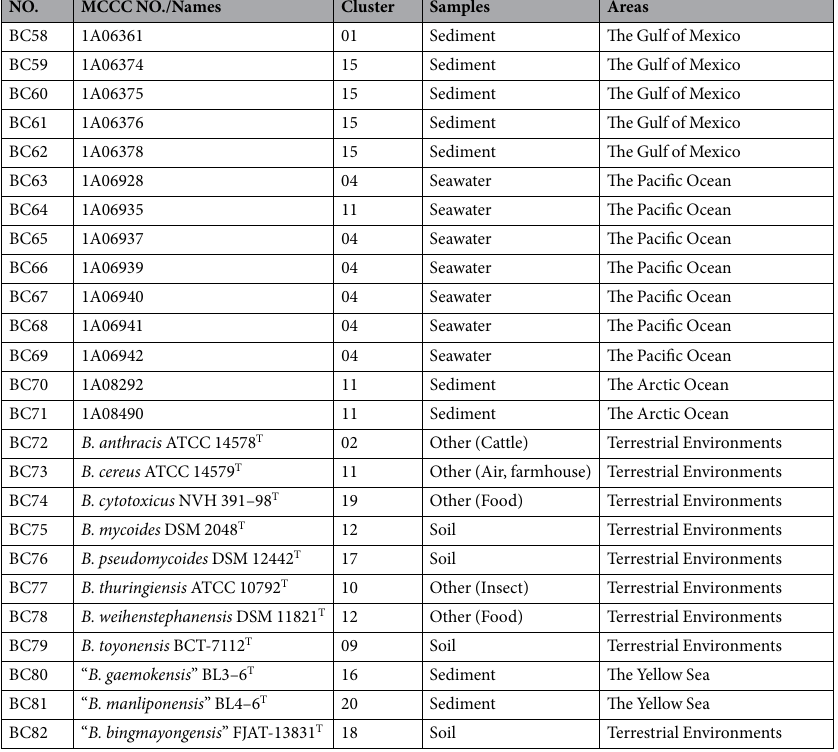
Table 1. Complete list of 82 strains used in this study with detailed